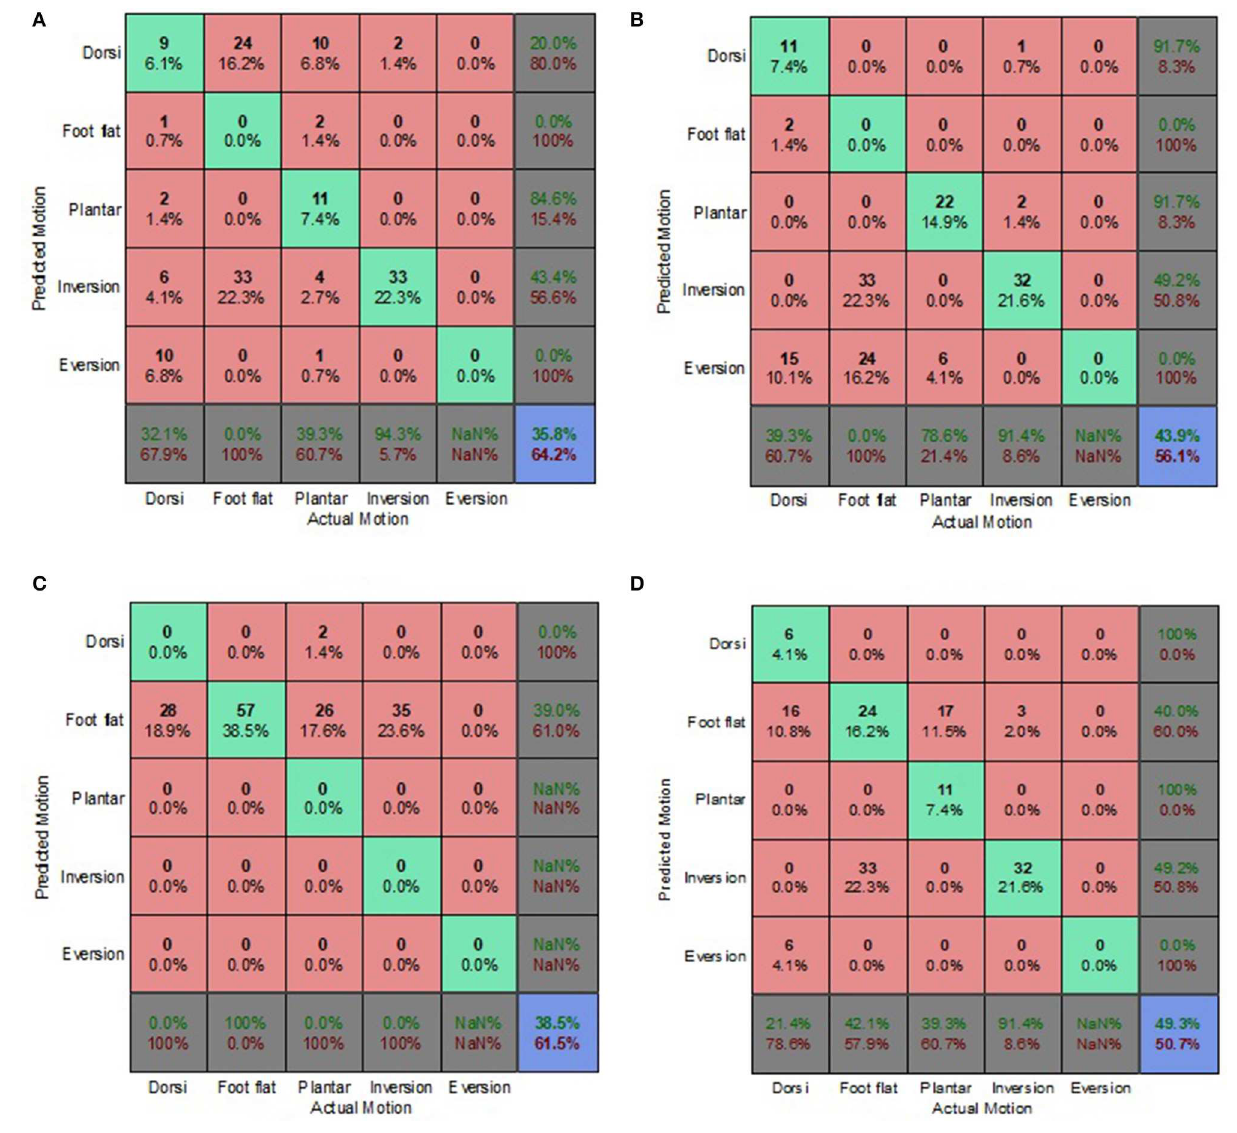
FIGURE 3 | Optimal Condition Combined Data Set—Generic Approach. (A) Tree, (B) LDA, (C) Deterministic, and (D) Voting